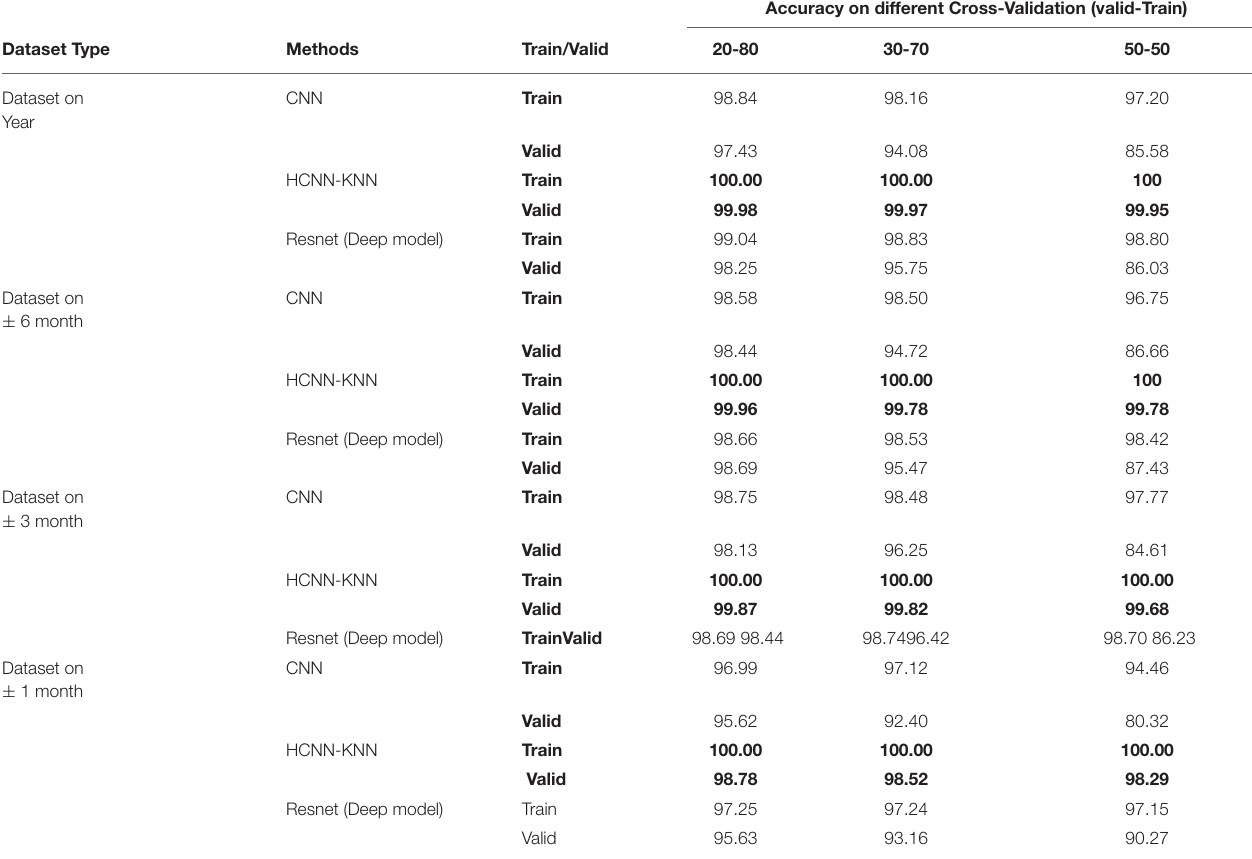
TABLE 5 | Evaluation of accuracy on different cross-validation on a